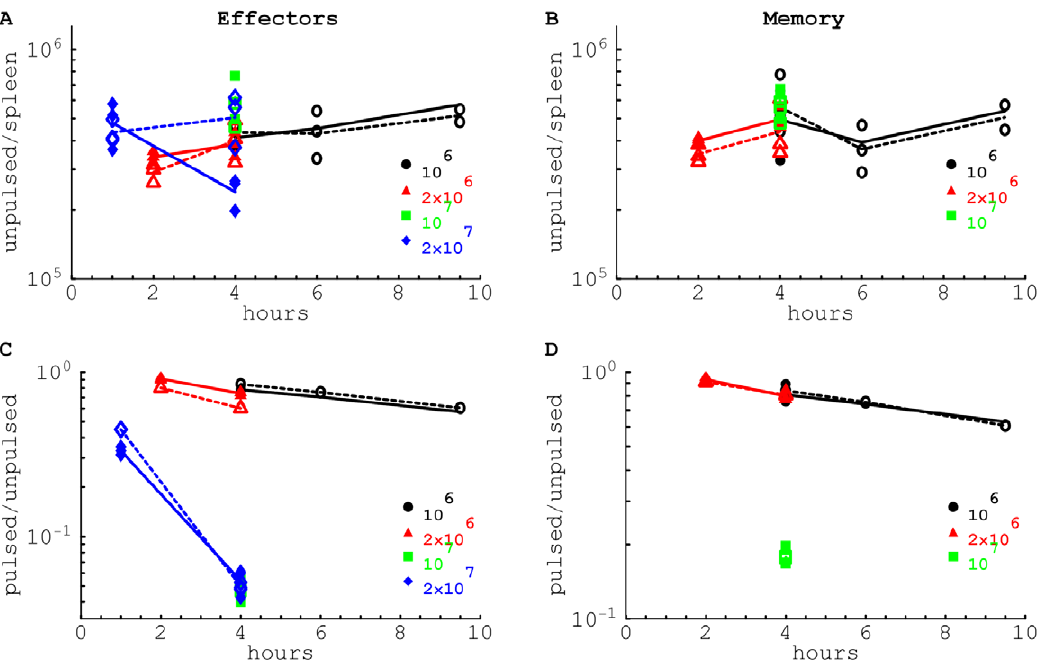
Figure 2. Fits of the mathematical model to data involving adoptive transfer of different numbers of GP33-specific effector (panels A&C) or memory (panels B&D) CD8 + T cells. Panels A and B show that the number of unpulsed targets in the spleen at different times after cell transfer remains approximately constant. Panels C and D show the decrease in the ratio of the frequencies of peptide-pulsed and unpulsed targets in the spleen over time. Different symbols denote data from different adoptive transfer experiments with 10 6 , 2 | 10 6 , 10 7 , or 2 | 10 7 P14 cells transferred. Filled symbols denote individual mouse measurements with the averages per time point being connected by solid lines. Open symbols are the model predictions with averages being connected by dashed lines. Parameters providing the best fits of the model are shown in Table 1. Note that in panel A, the model can not predict the decline in the number of unpulsed targets with time in experiments with transfer of 2 | 10 7 GP33- specific effectors. Such decline in the number of unpulsed targets in the spleen is unexpected and is most likely due to a measurement error.